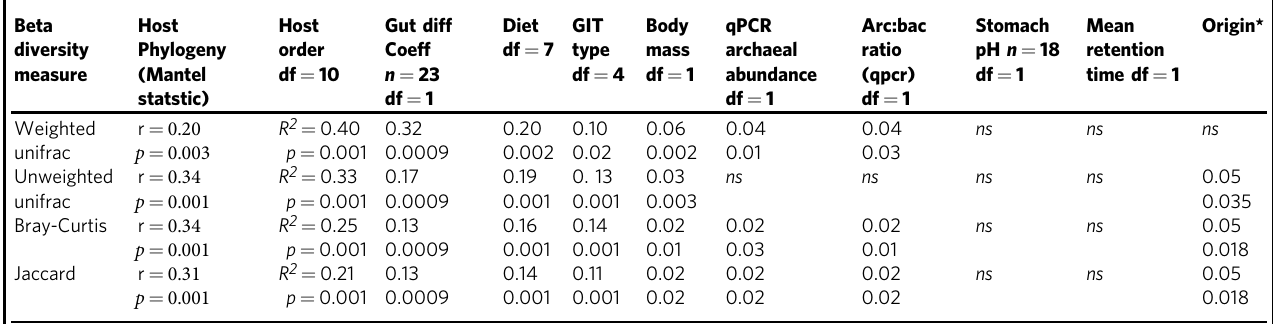
Table 1 Factors that in fl uence the beta diversity of archaea in